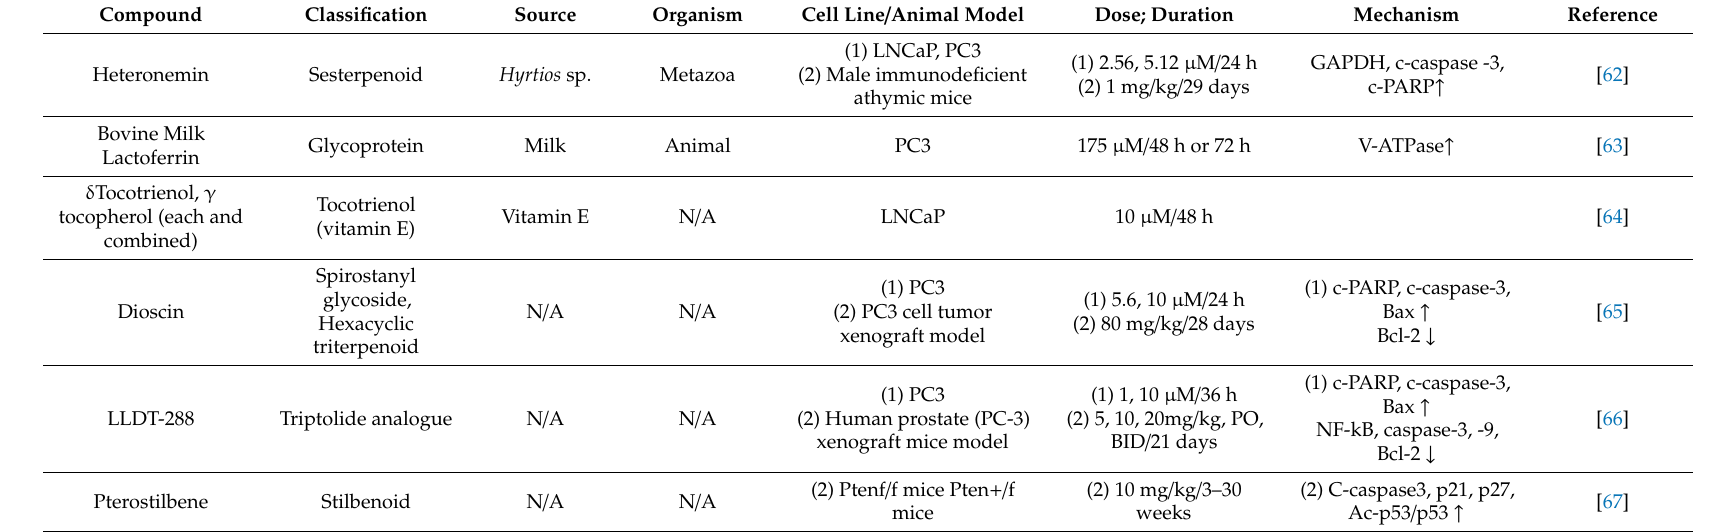
Table 3. Apoptosis inducing dietary compounds originated from other